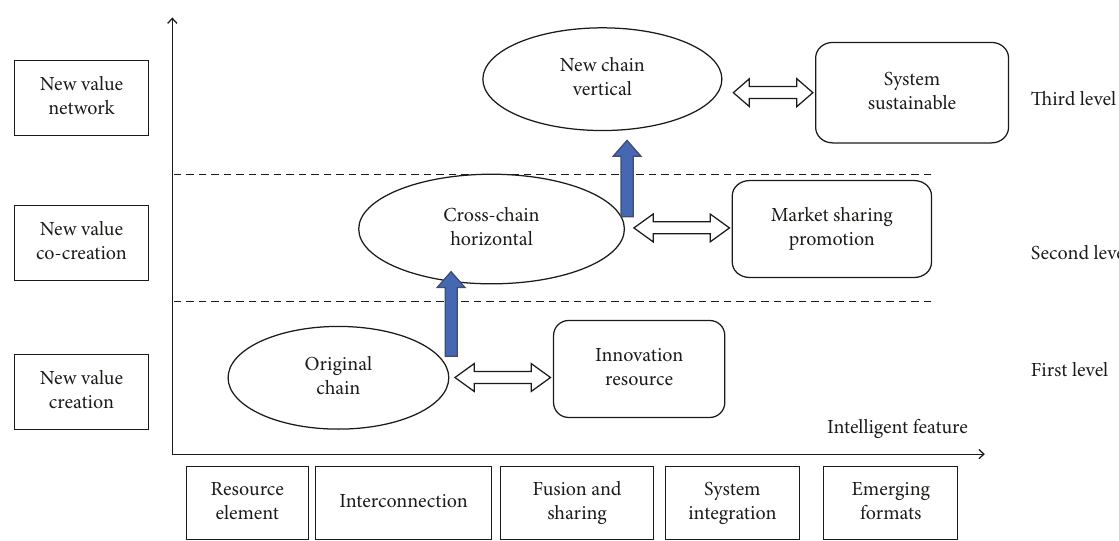
Figure 1: Dynamic system model of the value chain